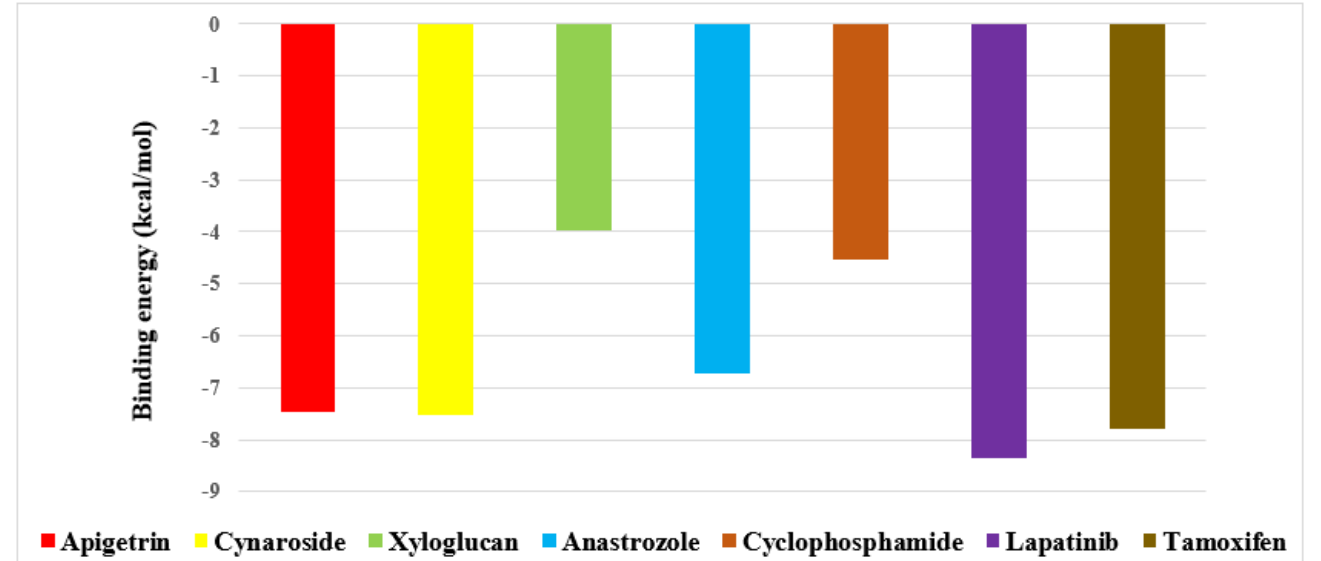
Figure 9. Graphical representation of the binding energy ( − kcal/mol) of the top three phytochemicals (apigetrin, cynaroside and xyloglucan) and standard drugs (anastrozole, cyclophosphamide, lapatinib and tamoxifen) in complexation with EGFR.